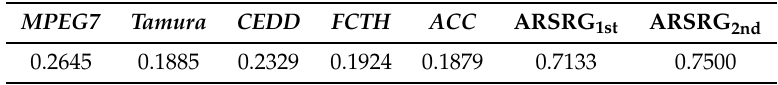
Table 6. Quantitative comparison using the MRR measure, among some features available in the Lucene Image Retrieval (LIRe) [35] system and the ARSRG matching on the dataset in [26]. MPEG7